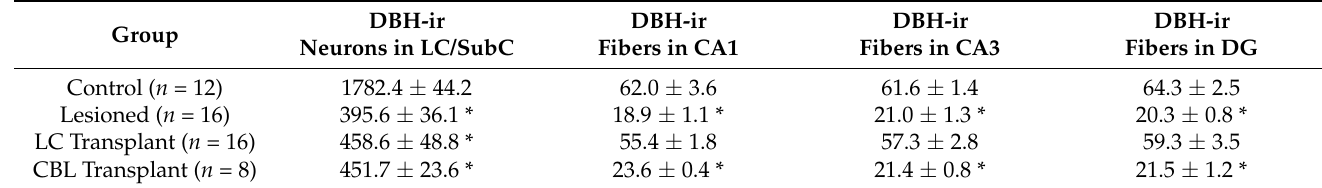
Values indicate the estimated total number of DBH-immunoreactive neuronal pro fi les in the LC, and the relative density scores (± SEM) of the DBH-positive innervation in each of the various sub- divisions of the hippocampal formation, i.e., Cornu Ammonis (CA) 1 and 3 and the Dentate Gyrus (DG). Asterisks indicate a signi fi cant di ff erence from Normal ( p < 0.01).